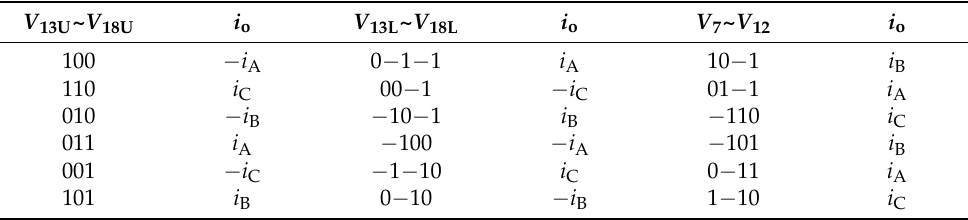
Table 1. Output vector and neutral point